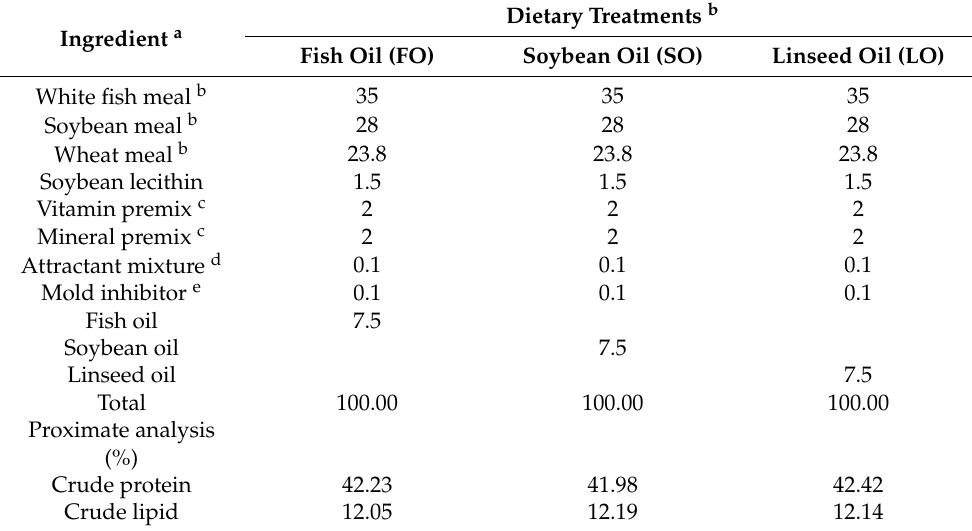
Dietary Treatments b